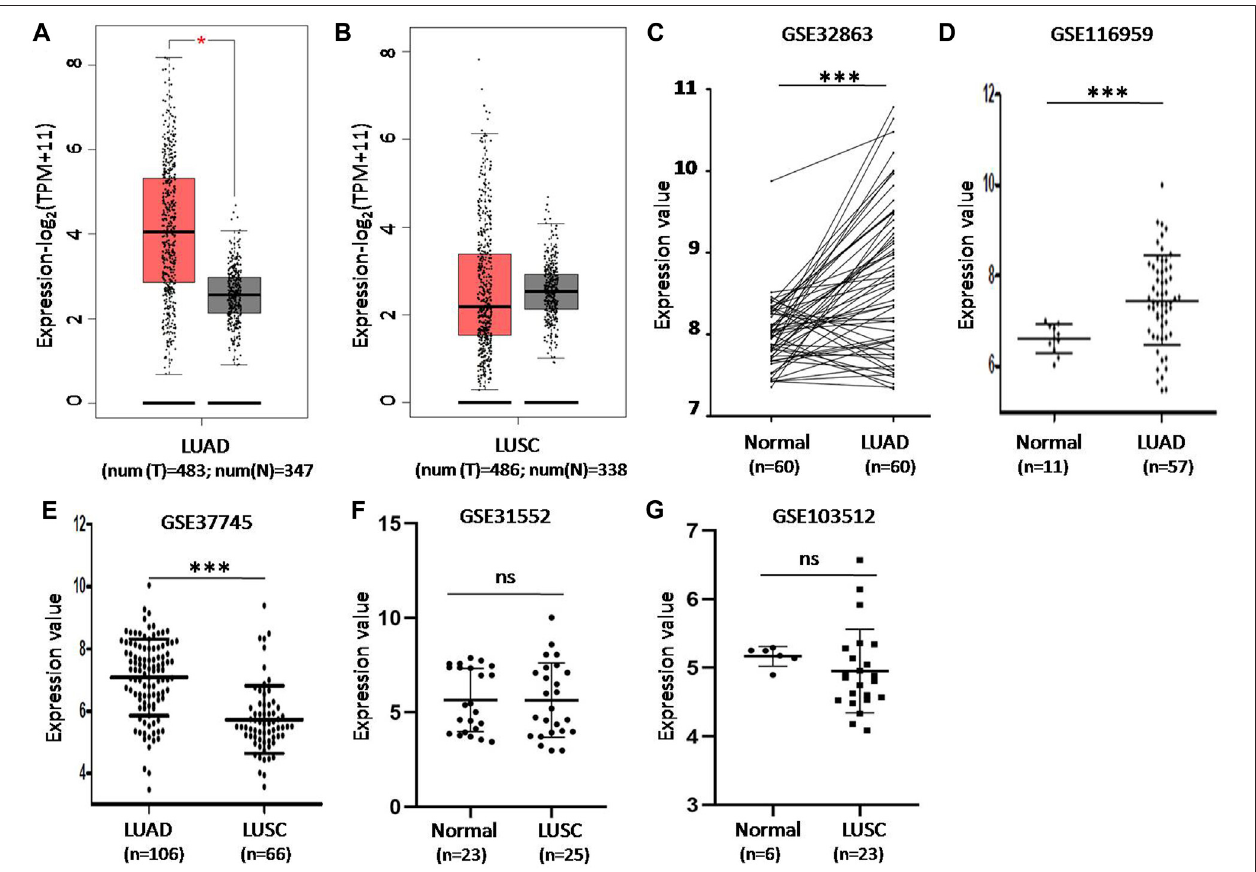
FIGURE1| ThedifferenceofCD73expressionlevelsinlungcancertumortissueandnon-tumornormallungtissueinGEPIA2andGEOdatabase. (A) CD73mRNA expression increased in LUAD tumor tissues. TPM: Transcripts Per Kilobase of exon model per Million mapped reads. (B) There were no signi fi cant difference of CD73 expression betweenLUSCtumortissuesandnon-tumornormaltissues. (C) DifferentialexpressionofCD73inGSE32683dataset. (D) DifferentialexpressionofCD73in GSE116959 dataset. (E) Differential expression of CD73 in GSE37745 dataset. (F,G) Differential expression of CD73 in GSE31552 and GSE103512 datasets * < 0.05; ** < 0.01; *** <